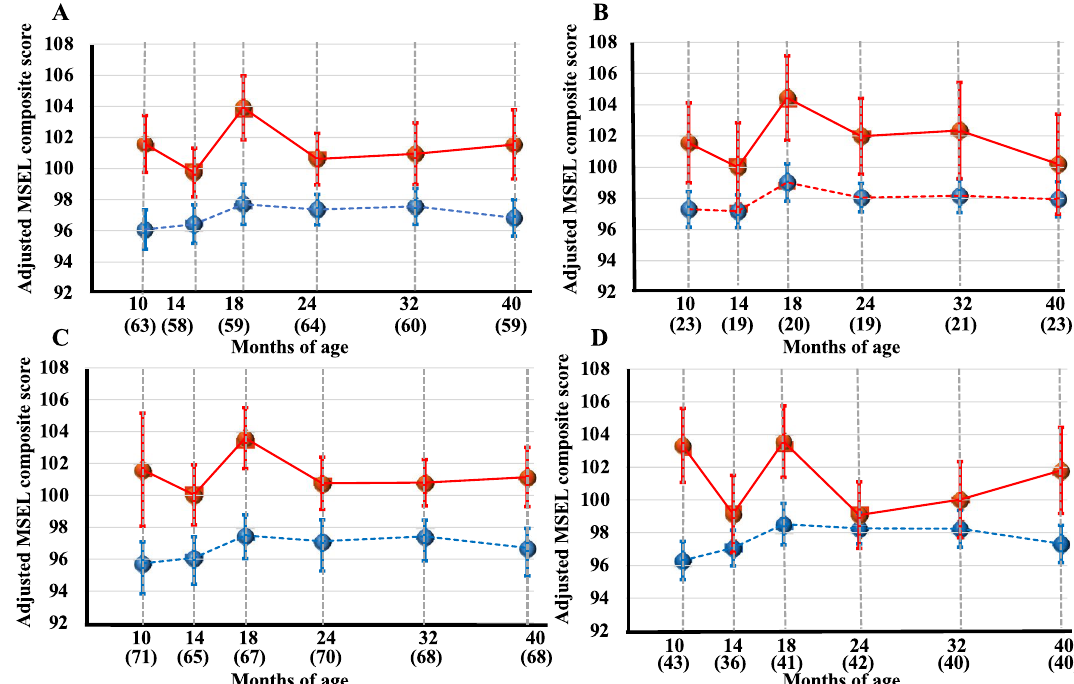
Figure 3. Chronological changes of Mullen Scales of Early Learning composite scores in each placental pathological finding during 10 to 40 months; ‘Thrombosis or Intramural fibrin deposition’ ( A ), ‘Avascular villi’ ( B ), ‘Fetal vascular malperfusion’ ( C ), and ‘Fetal inflammatory response’ ( D ) as significant predictors of the relatively higher MSEL composite scores in the infantile neurodevelopmental milestones by a mixed model analysis. Red and blue dots indicate MSEL composite scores with and without ‘Thrombosis or Intramural fibrin deposition’, ‘Avascular villi’, ‘Fetal inflammatory response’, and ‘Fetal vascular malperfusion’. Circles and error bars indicate the mean and standard error of the